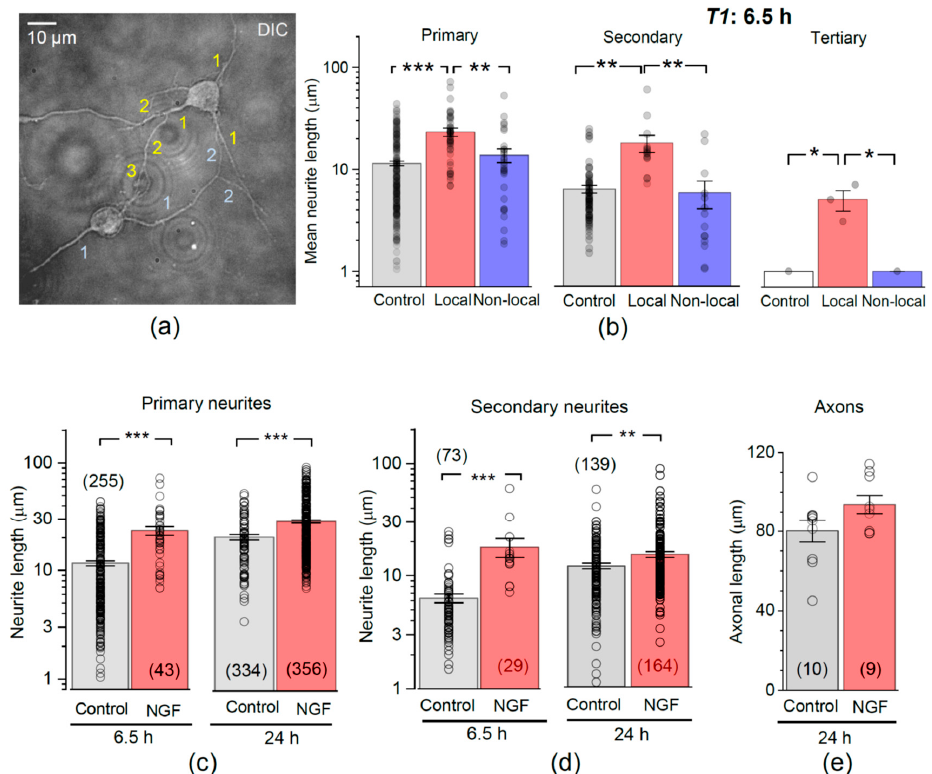
Figure 4. Encapsulated NGF boosts neurite branching. ( a ) Example (DIC channel) of two hippocampal neurons at 6.5 h post-plating in neuron-astrocyte co-culture, with the primary, secondary, and tertiary neurites as indicated (1, 2, and 3, respectively). ( b ) Statistics for individual neurite lengths, at various branch order, in control and in the presence of encapsulated NGF, for local (<50 µ m from capsules) and non-local (>50 µ m) neurons, as indicated. Dots, neurite measurements pooled for individual cells; bars, mean ± s.e.m.; * p < 0.05; ** p < 0.01, *** p < 0.001 (two-tailed t -test). ( c , d ) Statistical summary for the length of primary ( c ) and secondary branches ( d ) at 6.5 h and 24 h post-plating in control and in the presence of encapsulated NGF, as indicated. Dots, individual neurite measurements; bars, mean ± s.e.m.; ** p < 0.01, *** p < 0.001 (two-tailed t-test). ( e ) Statistics for the length of individual axons, as identified at 24 h post-plating, in control and in the presence of NGF-loaded microcapsules, as